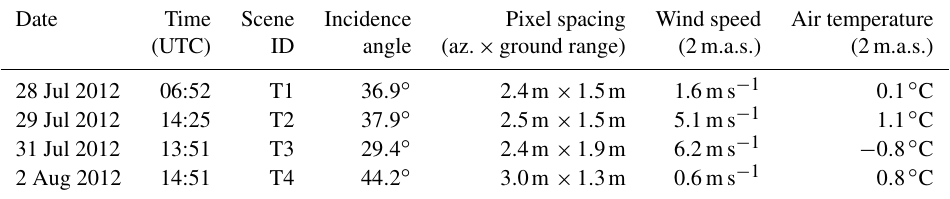
Table 1. Overview of the satellite scenes.